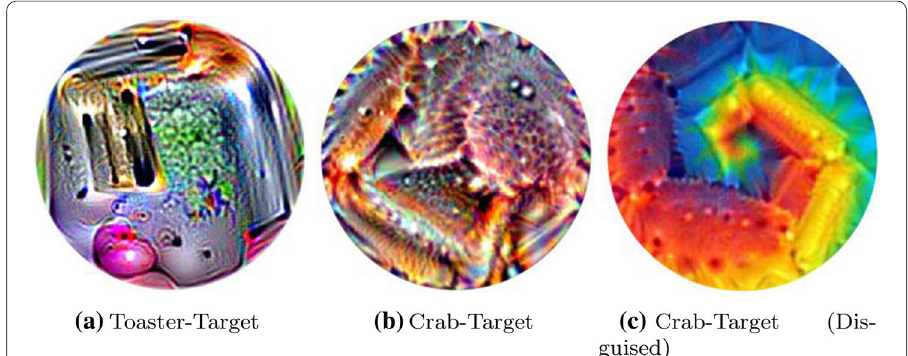
Fig. 2 The used adversarial patches for evaluation, as generated by [3]. Whereas the patches are imperceptible by humans, they are perceptible and salient to the CNN